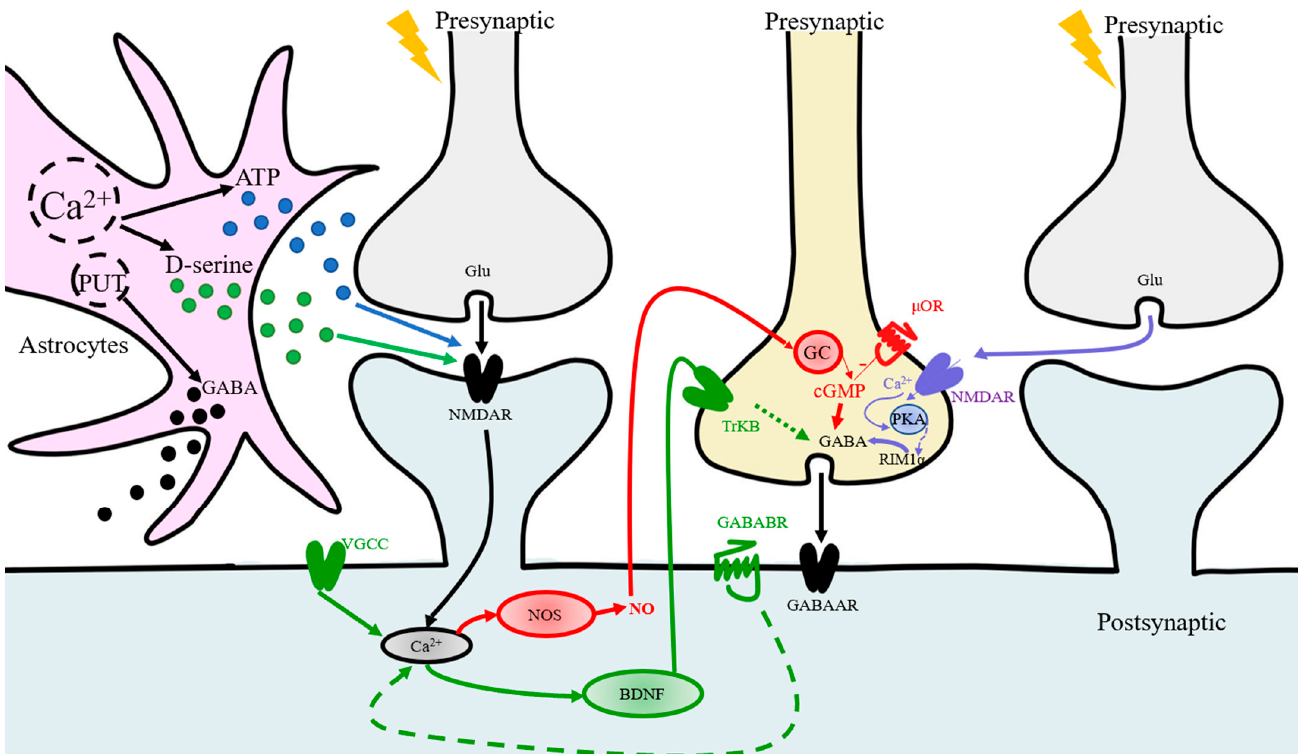
Figure 2. Mechanism of iLTP and the underlying mechanism of astrocyte regulation of iLTP. The red, green, and purple pathways represent the mechanism of NO-mediated long-term potentiation, BDNF-TrkB_iLTP, and NMDAR-dependent _iLTP, respectively. Astrocytes release ATP and D-serine by increasing intracellular calcium ions, which is necessary for NMDA-dependent LTP. Polyamine putrescine (PUT) is an important source of astrocyte GABA production. Signi fi cant GABA release suggests that the astrocyte Glu-GABA exchange mechanism is the key to limiting ictal discharge. This evidence may show a new mechanism for regulating iLTP.